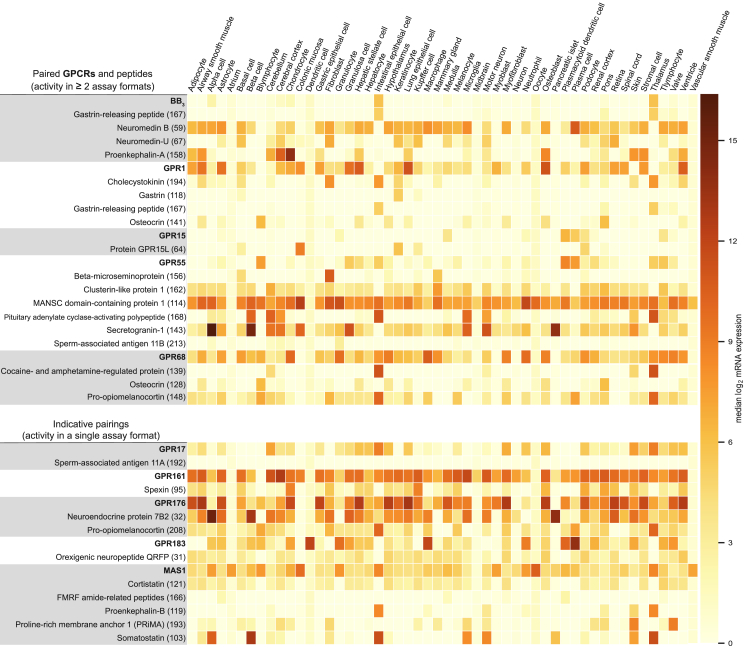
mRNA Expression Profiles of Paired Peptide Ligand Precursors and Receptors, Related to Figure 4Human tissue expression profile of peptide-receptor pairs. Some receptors or precursors have low abundance (e.g., FMRF amide-related peptide) or restricted expression patterns (e.g., BB3, gastrin-releasing peptide), whereas the majority are ubiquitously expressed (source data from massive mining of publicly available RNA-seq data for 52 tissues provided by ARCHS4). Peptides are cleaved and secreted from their tissue of origin and may act at distant tissues.